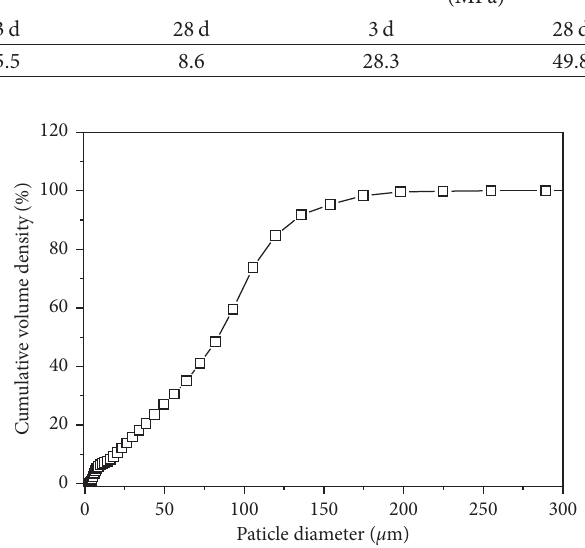
Figure 3: Cumulative particle size distribution of